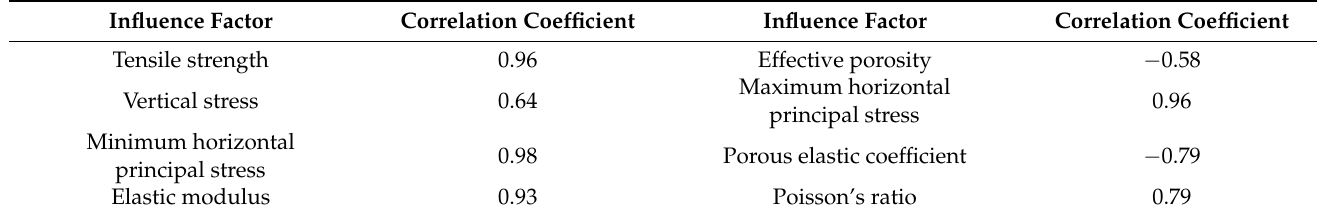
Table 4. Correlation analysis results of breakdown pressure of Well B after casting pipe